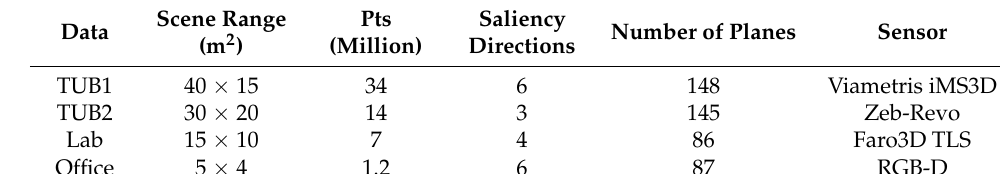
Table 1. Basic information on the datasets in our experiments.